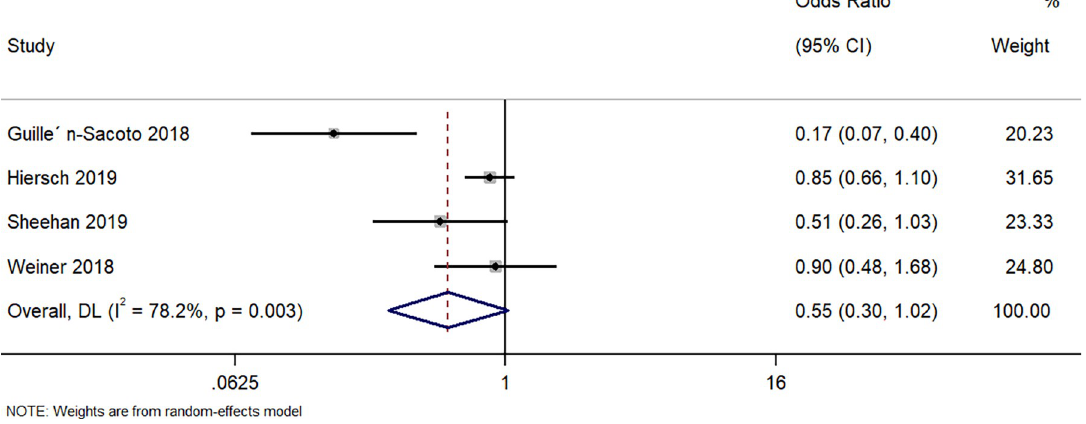
PLOS ONE | https://doi.org/10.1371/journal.pone.0280754 January 25,